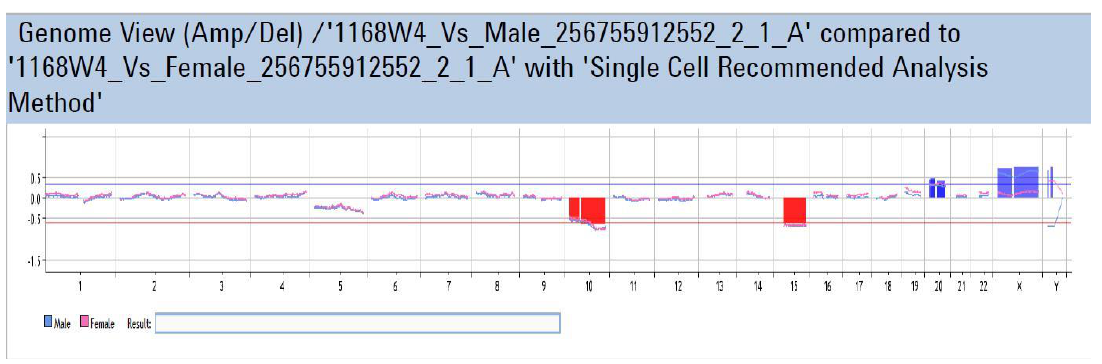
Figure A2. Male embryo, euploid: father mutation on PMM2, exon 5, c.385G>A, and mother mutation on PMM2, exon 6, c.470T>C.